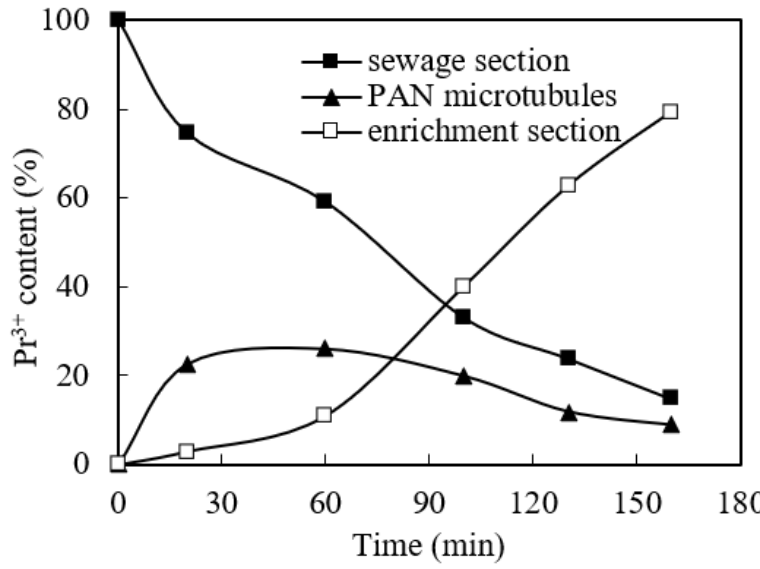
Figure 15. Retention in PAN microtubules and stripping effects.